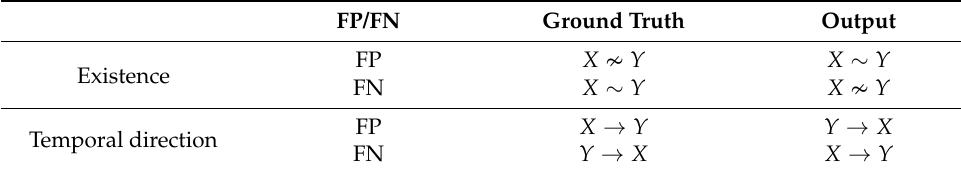
Table 12. Descriptions of FP and FN in anomaly detection.